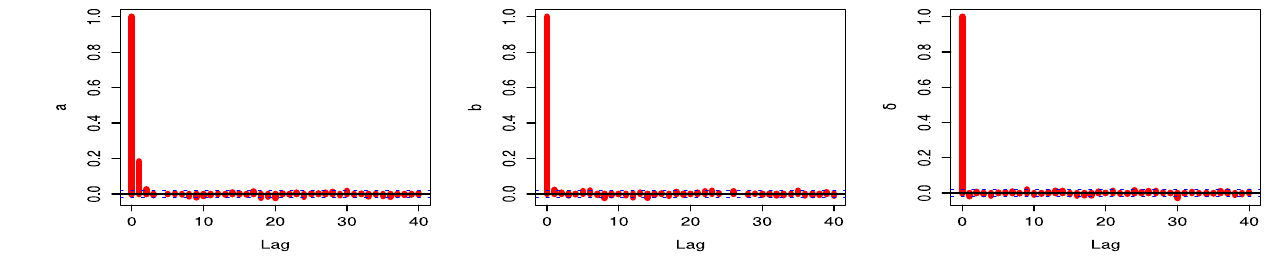
Figure 15. ACF plot of MCMC results for the United Kingdom data set.